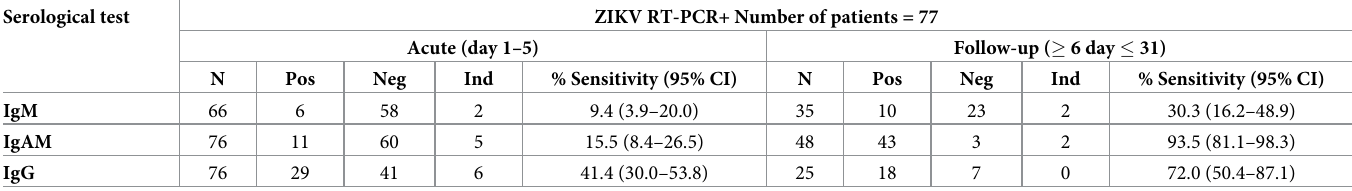
N represents the number of patients with a sample that was tested for the corresponding immunoassay; some patients have both acute and follow-up samples: IgM, n = 34; IgAM, n = 47; IgG, n =